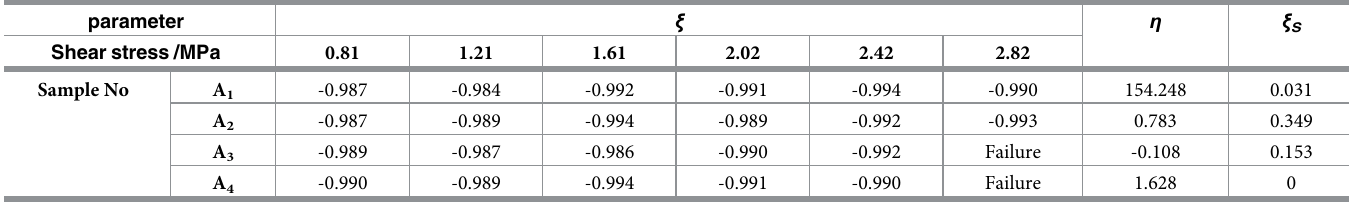
Table 3. Parameter inversion results under multi-stage shear creep